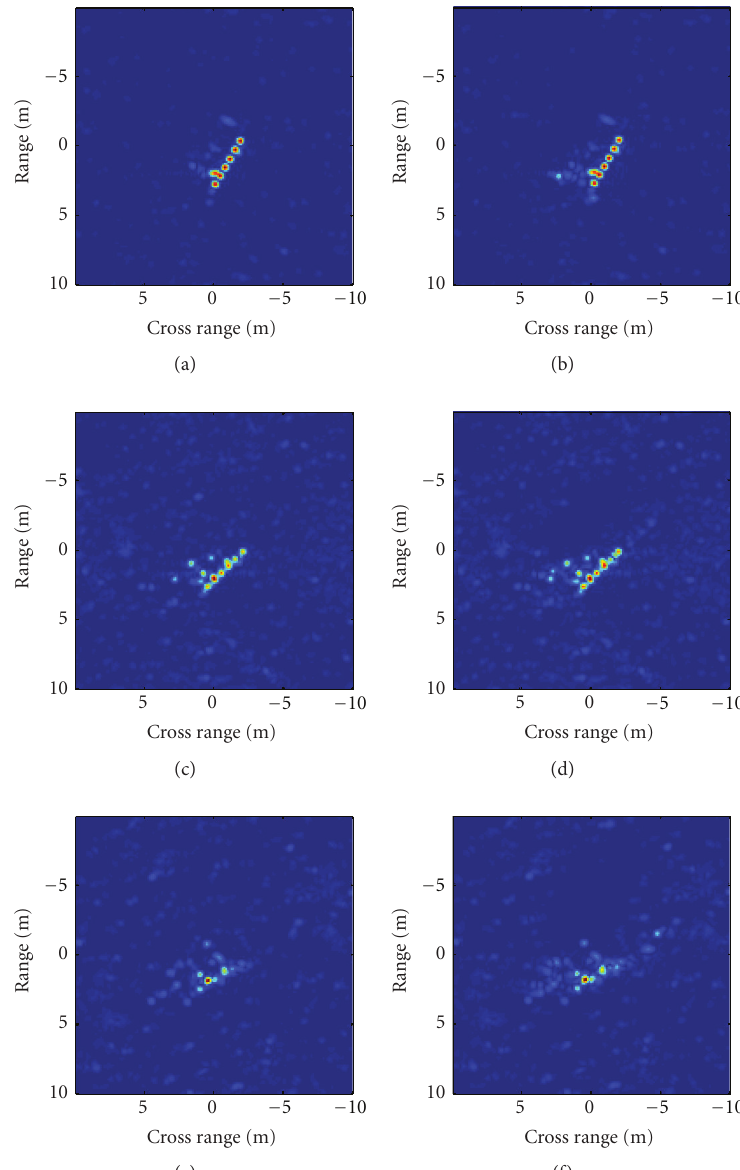
F 8: e 2D HH-polarization “superposed” and “combined” SAR images of the tank target and Gaussian rough surface, in which the incident angle is ( set as azimuth